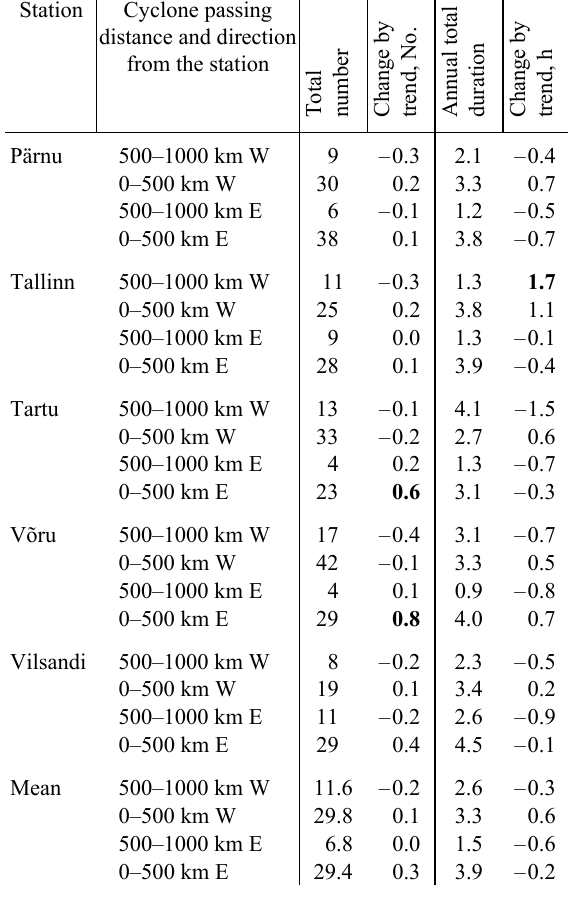
Table 2. Total number and annual total duration (hours) of thunderstorms related to SCs grouped by stations and by cyclone trajectories: passing Estonia from the west (W) and east (E) in distance intervals 0(cid:150)500 km and 500(cid:150)1000 km, and their changes by trend during 1950(cid:150)2010. Statistically significant trends are marked in boldface Station Cyclone passing distance and direction